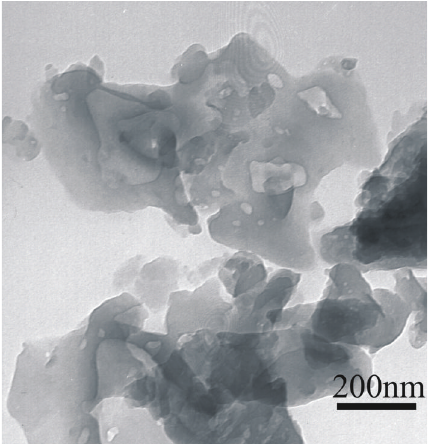
F 4: A typical TEM image of g-C